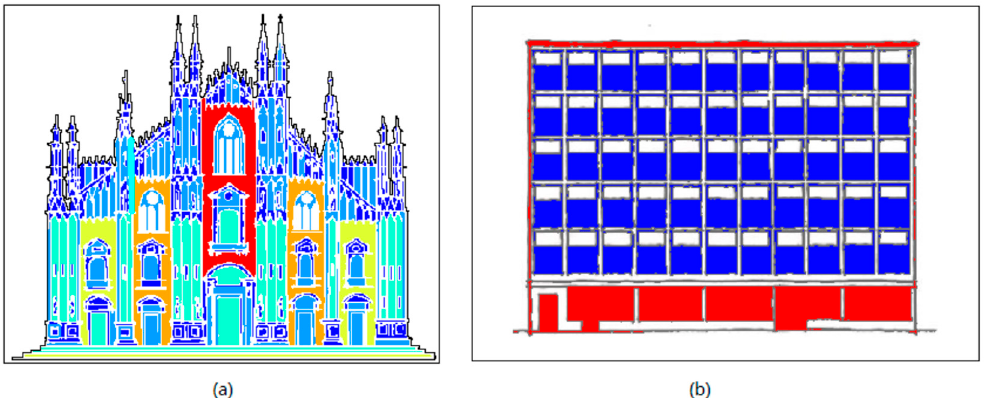
Figure 8. (Color online) Two building façades with di ff erent degrees of life or beauty. Source: This figure is create by the author based on the scanned black and white images from Kleineisel (1970). Note: The façade on the left ( a ) has a steep scaling hierarchy with six levels of scale (the six colors), whereas the one on the right ( b ) has a very flat scaling hierarchy with only two levels of scale (the two colors). More importantly, all blue centers of the right façade are exactly the same without any variation.